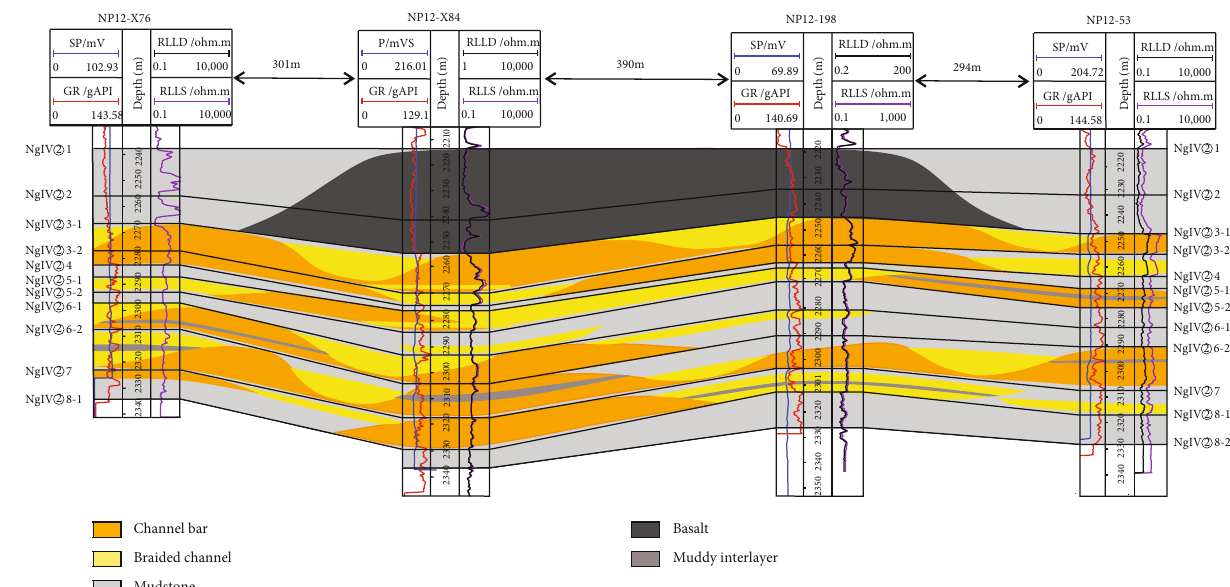
Figure 6: The vertical pro fi le of sedimentary facies in Nanpu 1-29 Area. The study area and the scale of modern typical wandering braided river deposits and the scales of sedimentary architectural elements were